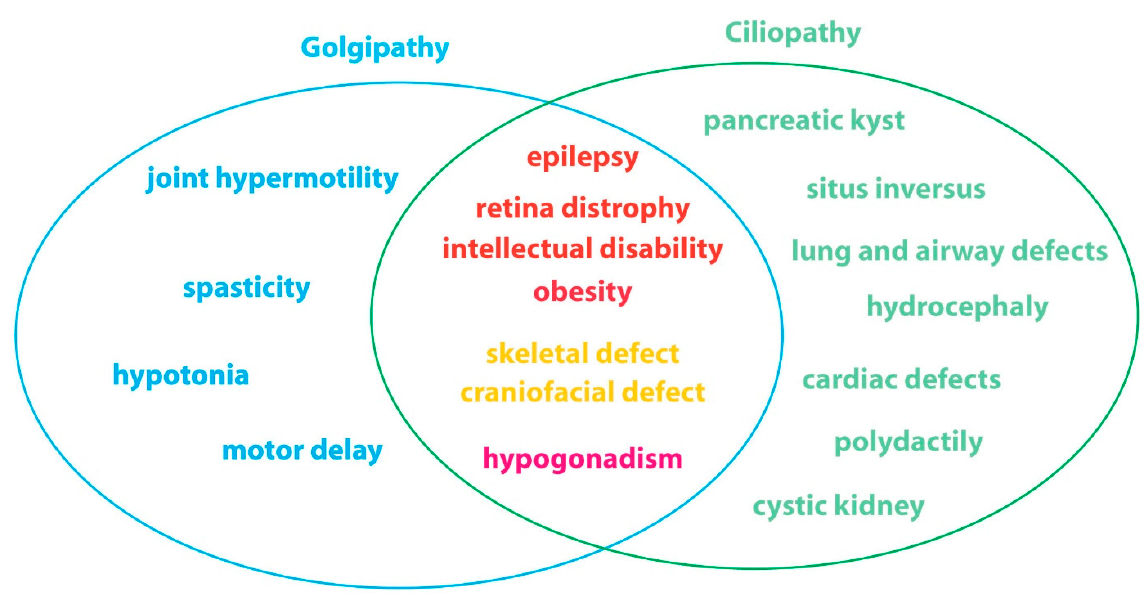
Figure 2. Electron microscopy pictures of hippocampal pyramidal cells in the mouse brain (unpublished and kindly provided by Jorge Diaz, Université Paris Cité, CNRS, Integrative Neuroscience and Cognition Center, F-75006 Paris, France). The basal body is visible in ( A ), the mother centriole in ( B , C ), and the axoneme of a primary cilium in ( B ). Whether the primary cilium extends close ( C ) or far ( B ) from the nucleus, Golgi apparatus saccules coat the base [6] .